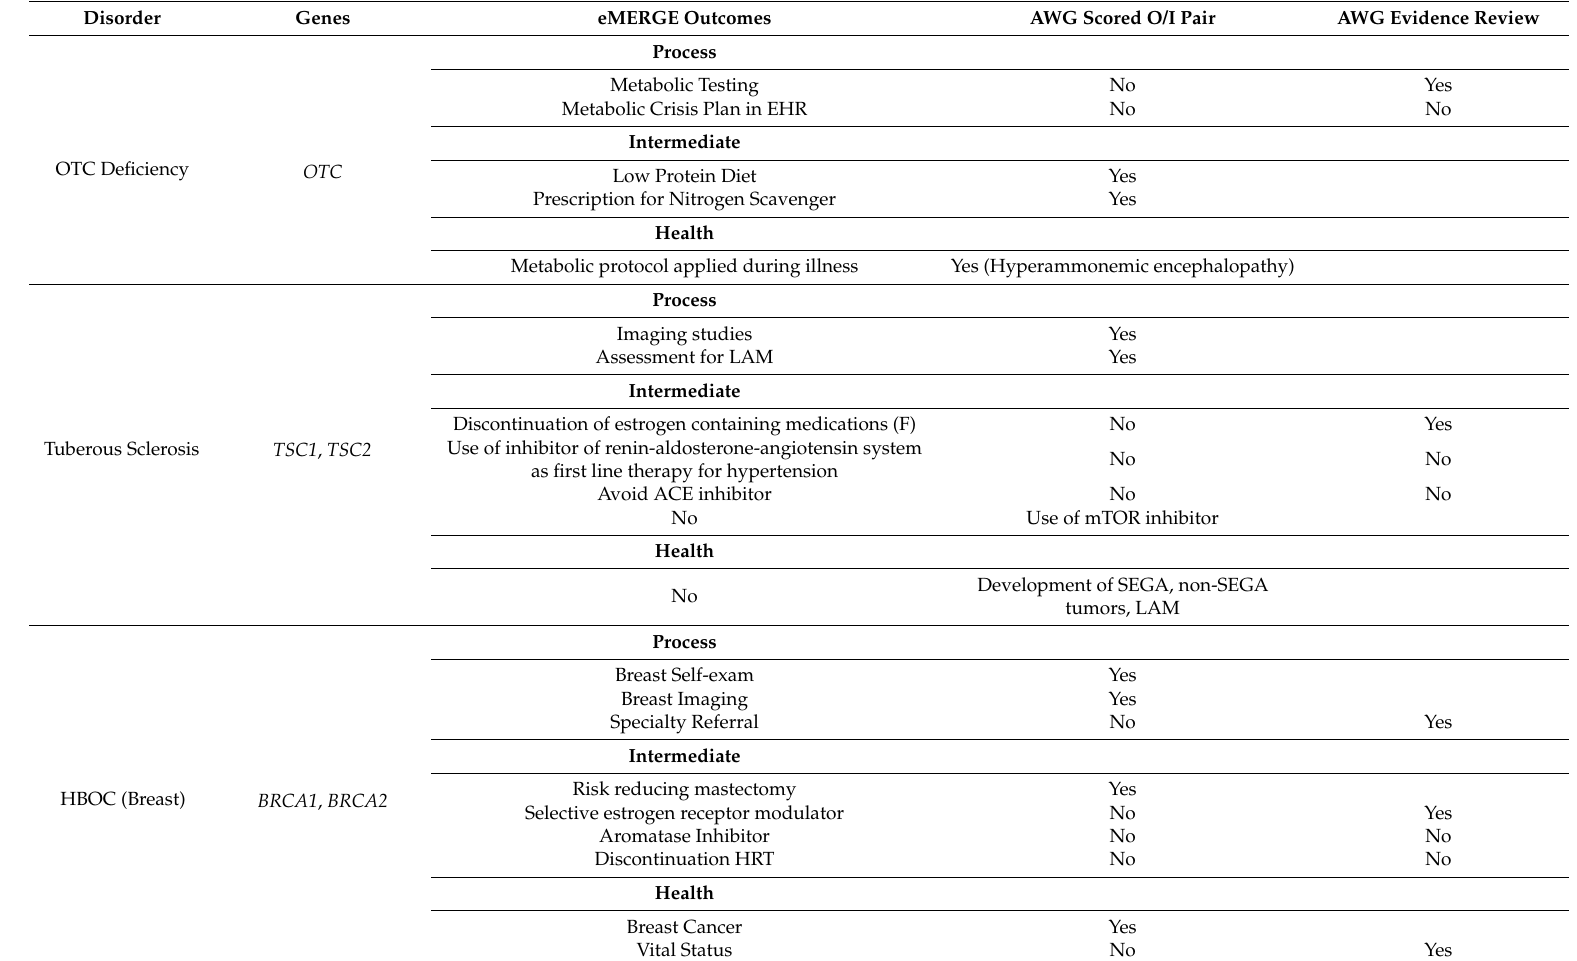
Table 2. Disorders with equivalent definitions from eMERGE and